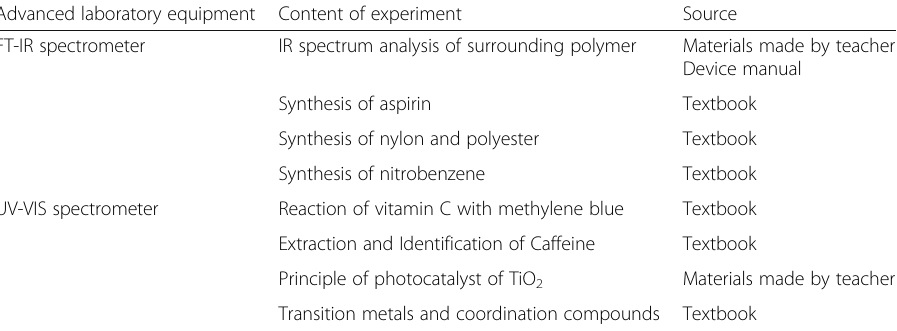
Table 1 Reconstruction of chemistry experiment topics for GI-ALE classes Advanced laboratory equipment Content of